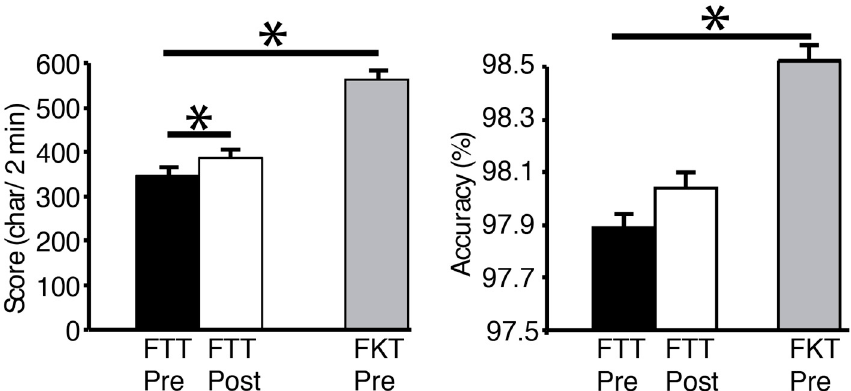
Figure 2. Score and accuracy of the FTT for pre and post practice, in comparison to the pre-test of the FKT. Scores significantly increased in the FTT from pre to post, but were significantly lower than the FKT during the pre-testing period. Subjects were more accurate with the FKT than the pre-test FTT. However, the FTT accuracy did not change after practice. * denotes significance ( p < 0.05) .